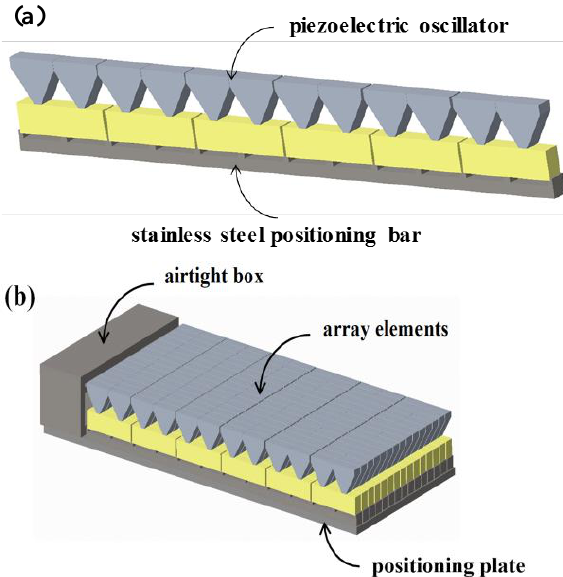
Figure 2. Structure of array element and underwater transducer based on shear mode. ( a ) One element of the underwater transducer; ( b ) 6 × 14 rectangular transducer array.